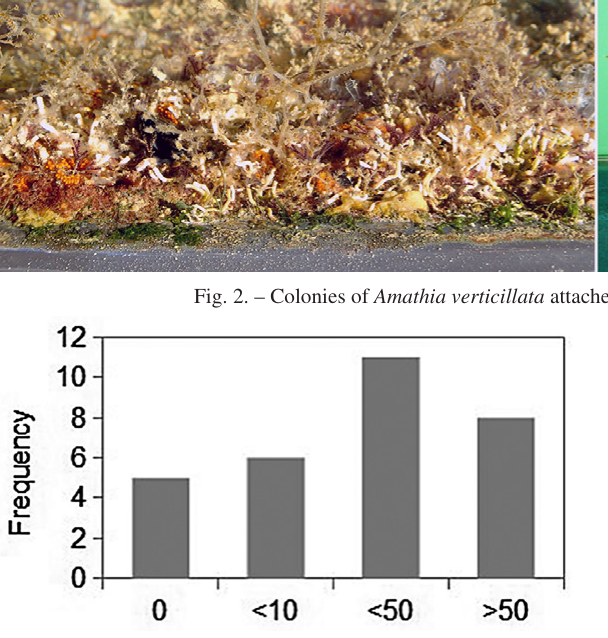
Fig. 3. – Colony number per pontoon examined.